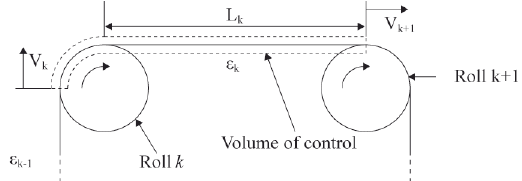
Fig. 2.Indices of web span between two consecutive rollers